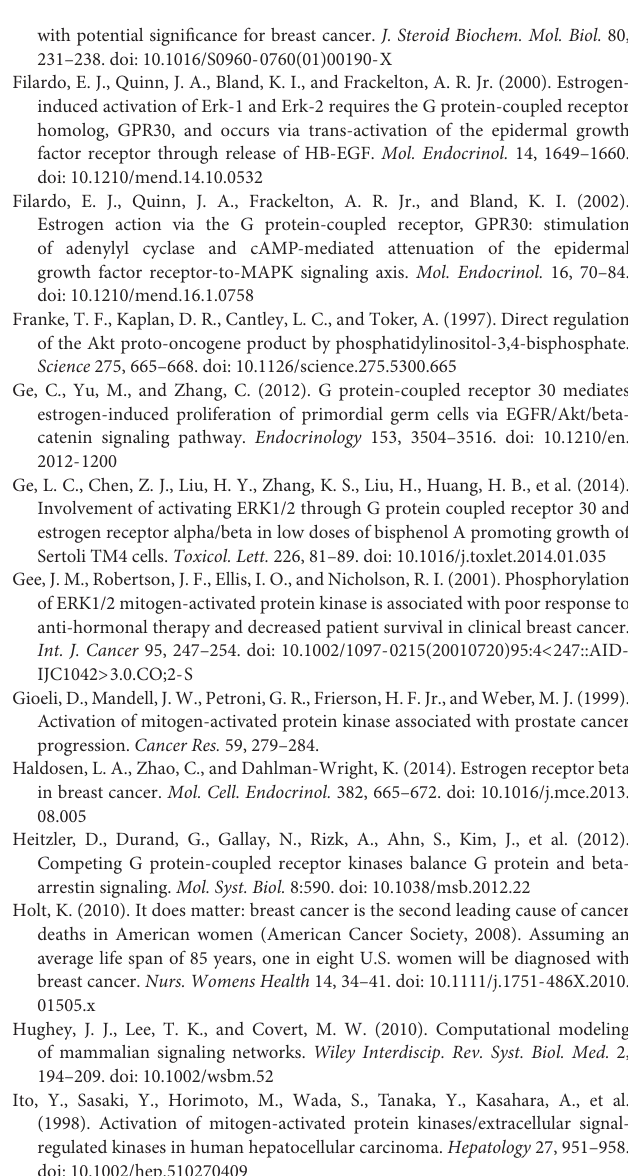
TABLE S1 | List of model reactions for simulated pathways. TABLE S2 | Summary of RNA sequence analysis for up-regulated genes. TABLE S3 | Summary of RNA sequence analysis for down-regulated genes. TABLE S4 | Gene ontology (GO) analysis of differentially expressed genes. TABLE S5 | Gene set enrichment analysis using KEGG mapping. TABLE S6 | List of up-regulated